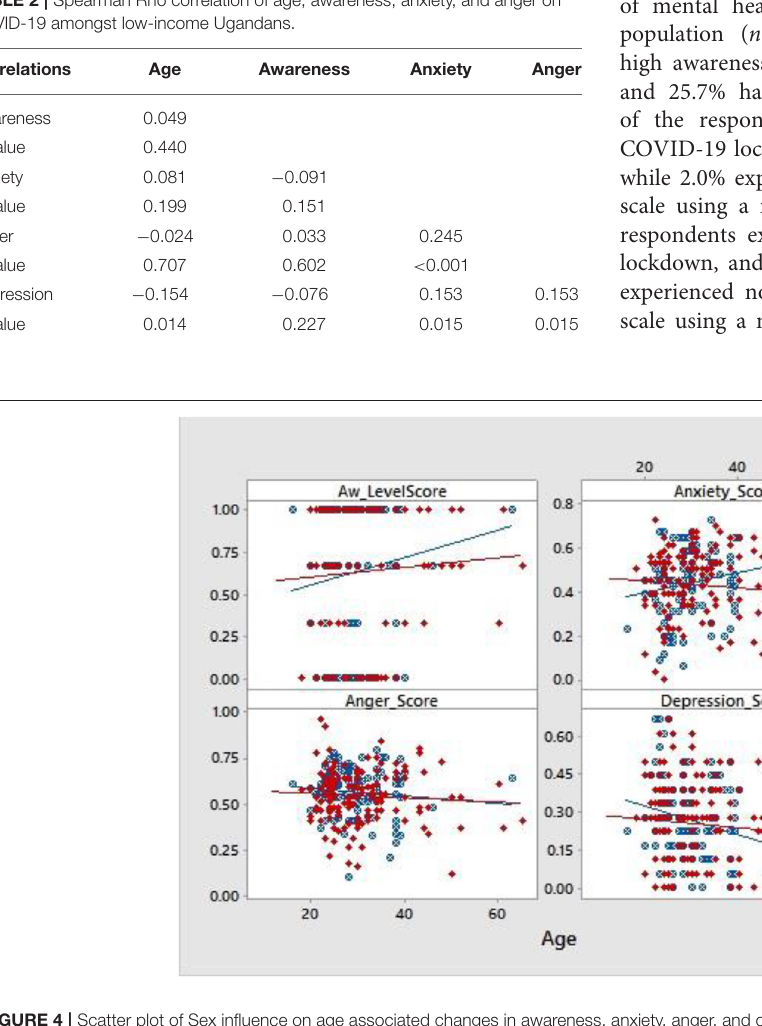
Frontiers in Public Health |